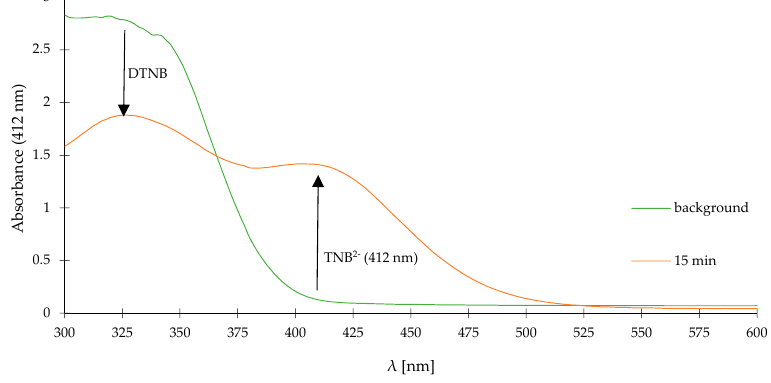
Figure 11. Time-dependent UV-vis absorption spectra of SH-free DTNB solution (green line- background) and its mixture with NaHS (0.1 mM, orange line) in the reaction buffer (pH 8.0) at room temperature. The absorbance at 412 nm was recorded 15 min after addition of NaHS.